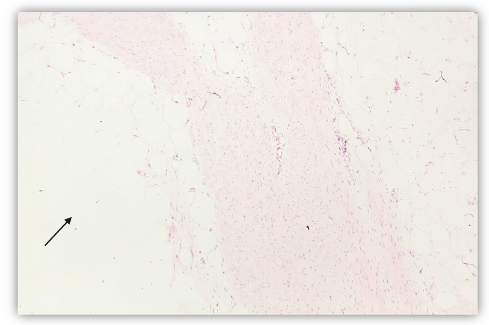
Figure 1: Characteristic trimorphic components: fibrous tissue (short thin arrow), mature adipose tissue (thick arrow), and myxoid matrix (long thin arrow). H & E stain (100X).